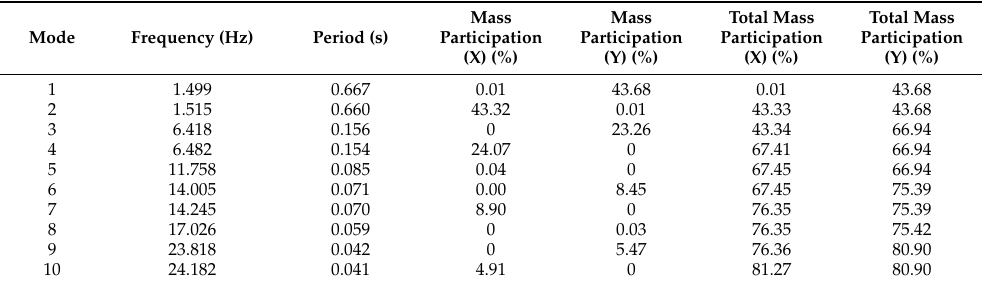
Table 9. Modal analysis results of the minaret model.